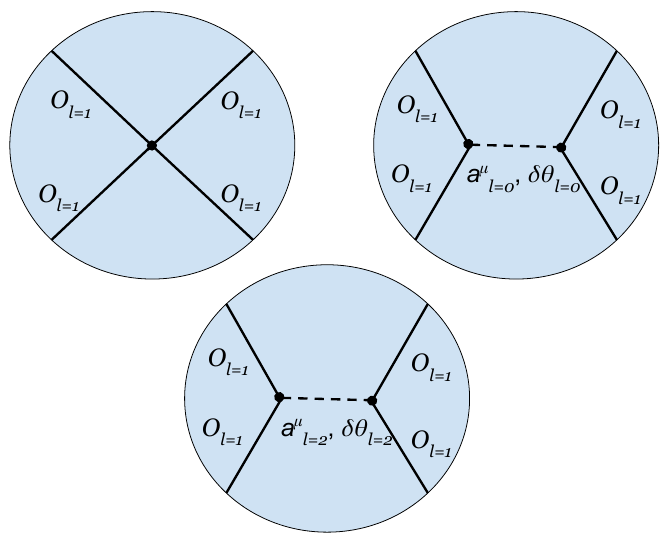
Figure 15. Witten diagrams for computing the connected part of the four-point function h O a O a O a O a i . Both l = 0 and l = 2 modes of δθ and a µ fields are exchanged in the exchange 1 2 3 4